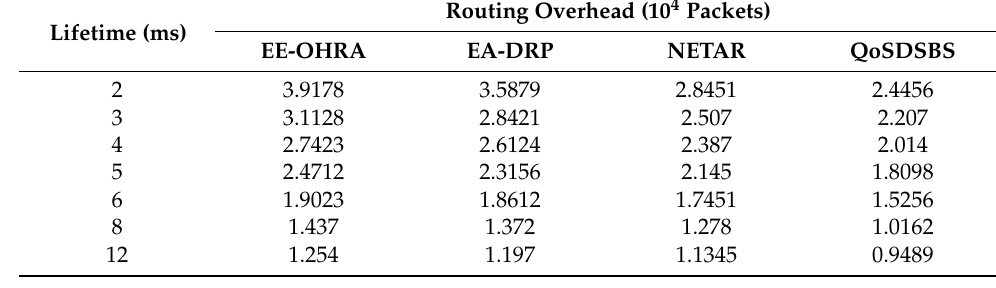
Table 5. Results of average path lifetime vs. routing control overload.